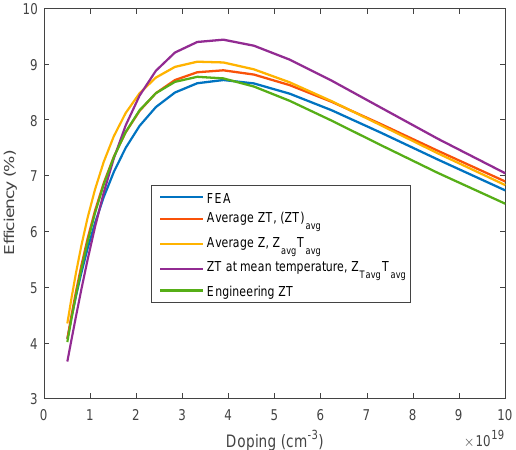
Figure 2. Thermoelectric material efficiency as a function of Bismuth telluride doping density with a hot side temperature of 250 °C and a cold side temperature of 30 °C calculated by different methods.